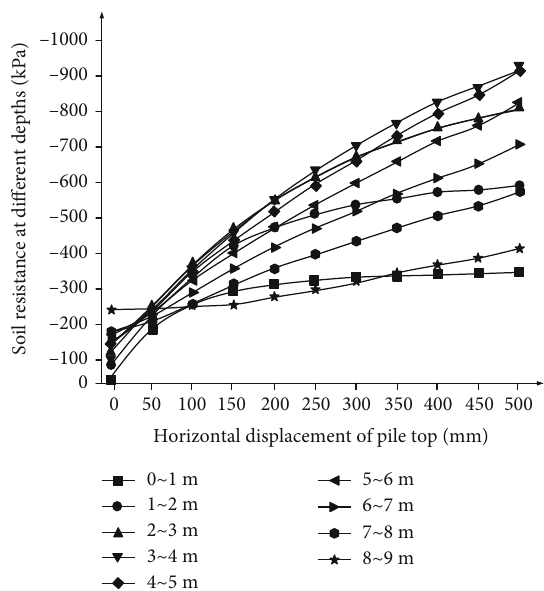
Figure 9: The growth law of soil resistance in front of the pile.